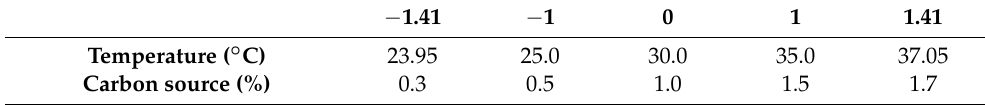
Table 1. Values used to construct the factorial design for T. longibrachiatum LMBC